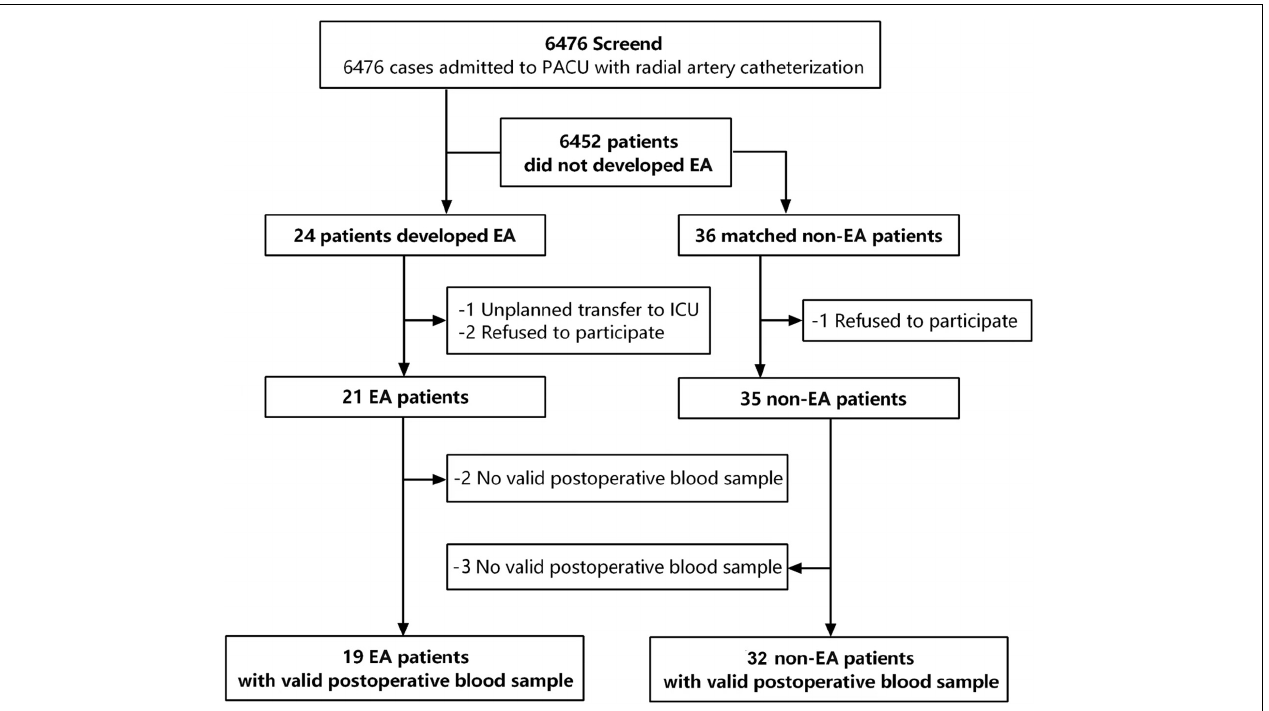
FIGURE 1 | Flow chart of the research design. 6,476 patients were screened for emergency agitation, and 24 patients developed EA. 36 non-EA patients were matched with a ratio of 1:1.5 according to gender, age, BSA, and surgery types. Finally, 19 valid preoperative blood samples in the EA group and 32 valid preoperative blood samples in the non-EA group were collected for further analyses.